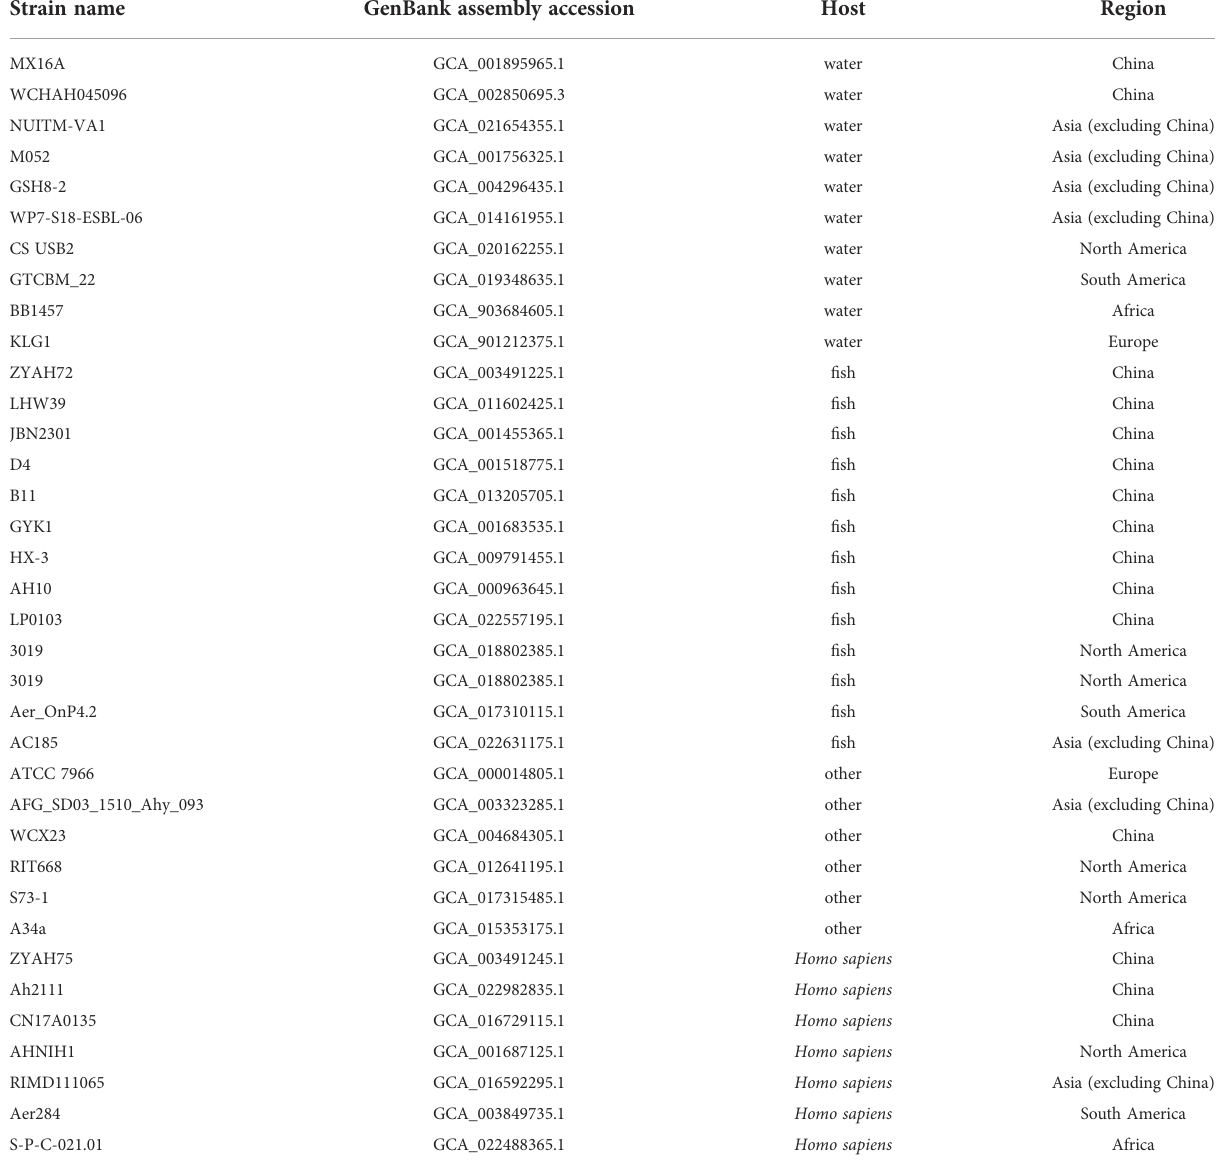
TABLE 4 Genomes information of 35 srains of A. hydrophila used in the present